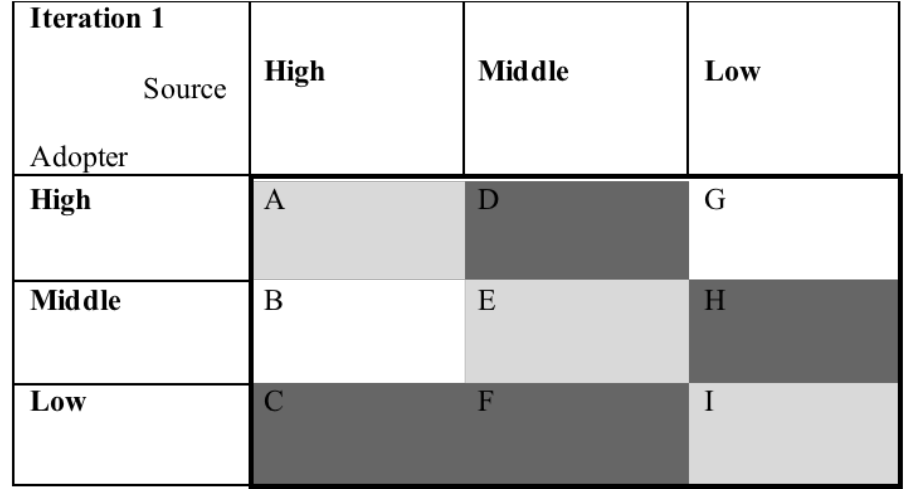
Fig. 3a. Iteration 1 Diffusion